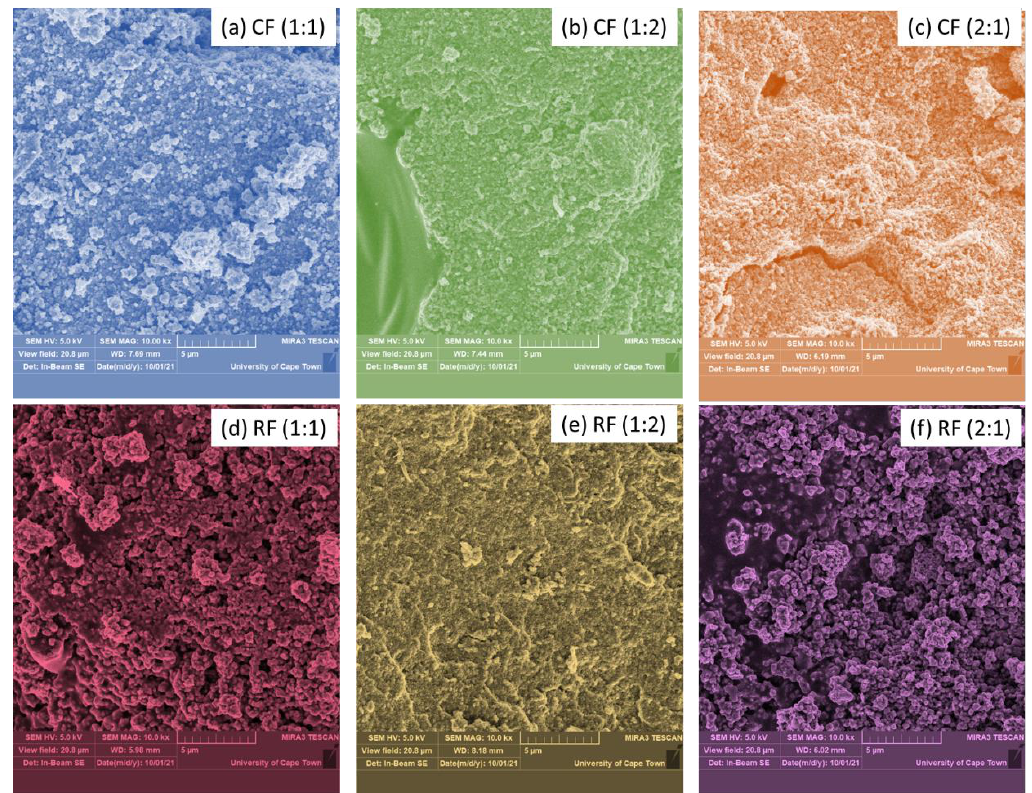
Figure 3. SEM images ( a – f ) of the magnetized